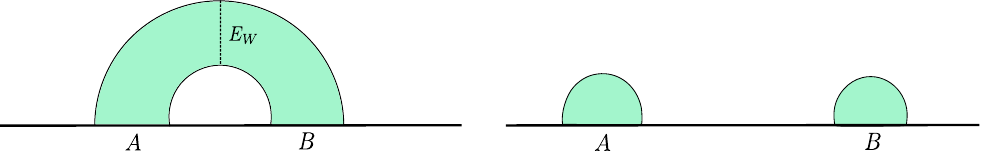
Figure 2: Left: The green shaded region represents the entanglement wedge for the subsystem A ∪ B . The dotted line gives the EWCS. Right: If the subsystems A and B are sufficiently far away, their entanglement wedge remains disconnected and the EWCS vanishes. (Adapted from [ 39 ]